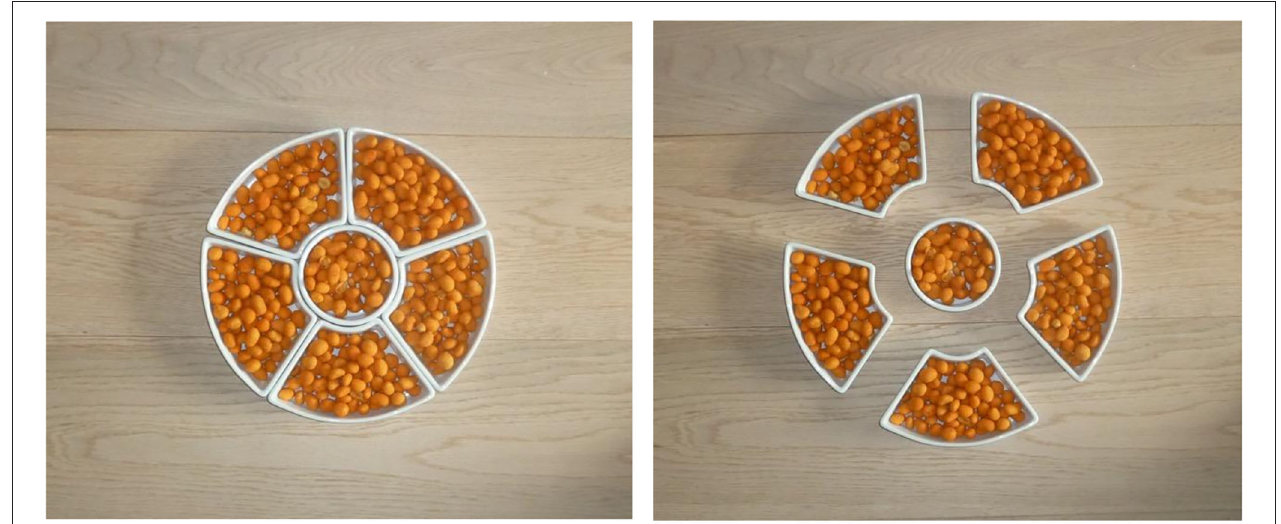
FIGURE 3 | Photographs of the tight (left) and loose (right) arrangement of cups (Study 3).